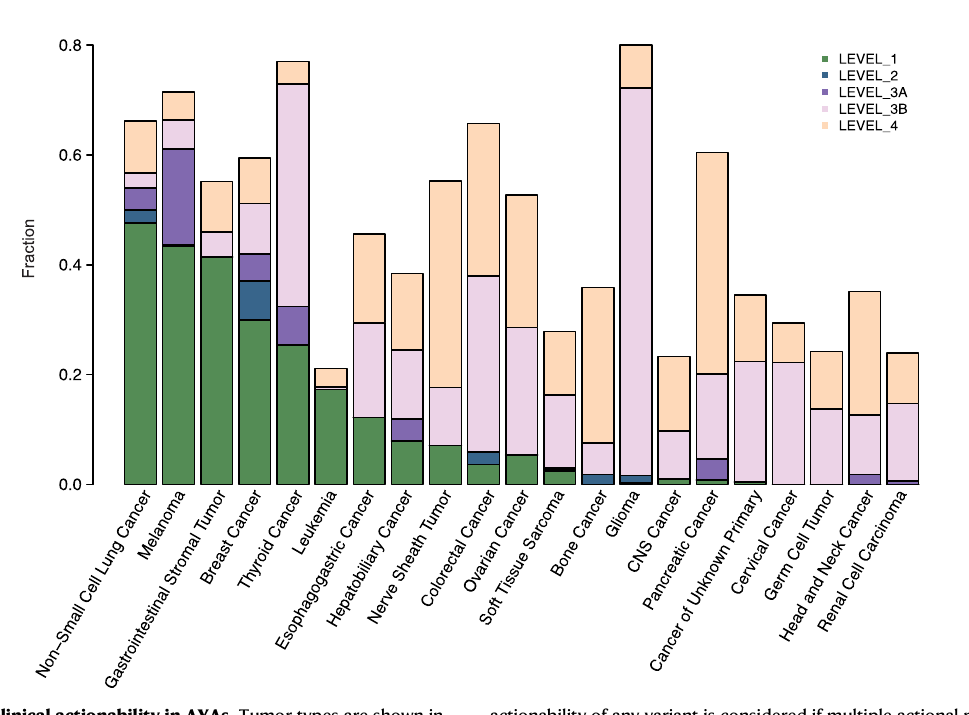
actionability of any variant is considered if multiple actional mutations are iden- ti fi ed.Onlytumortypeswithmorethan80AYAsampleswereincludedinthisplot. Source data are provided as a Source Data fi